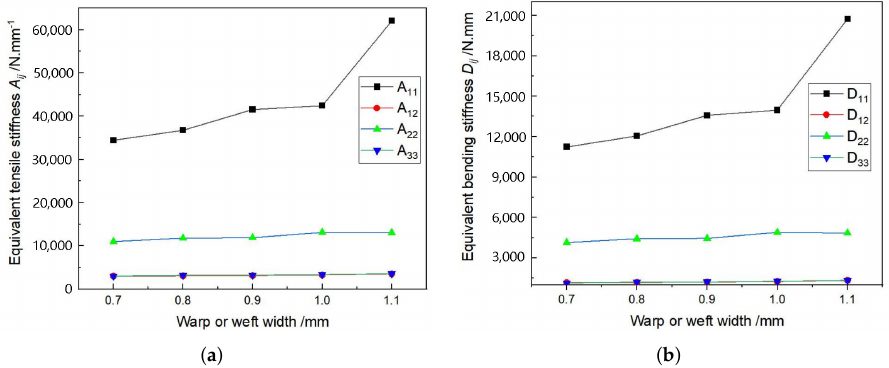
Figure 14. Influence of the warp (weft) yarn width on equivalent stiffness of 3D-TCP. ( a ) A ij ; ( b ) D ij